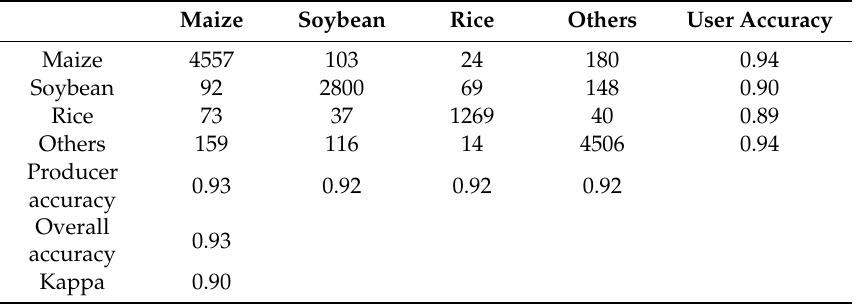
Table 3. Accuracy assessment using the interpreted images from Google Maps for the NEP.